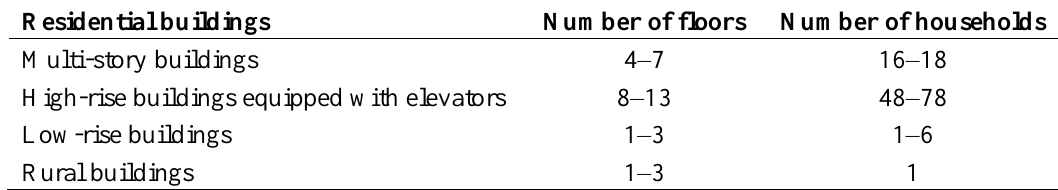
Table 3. Classification of building heights and